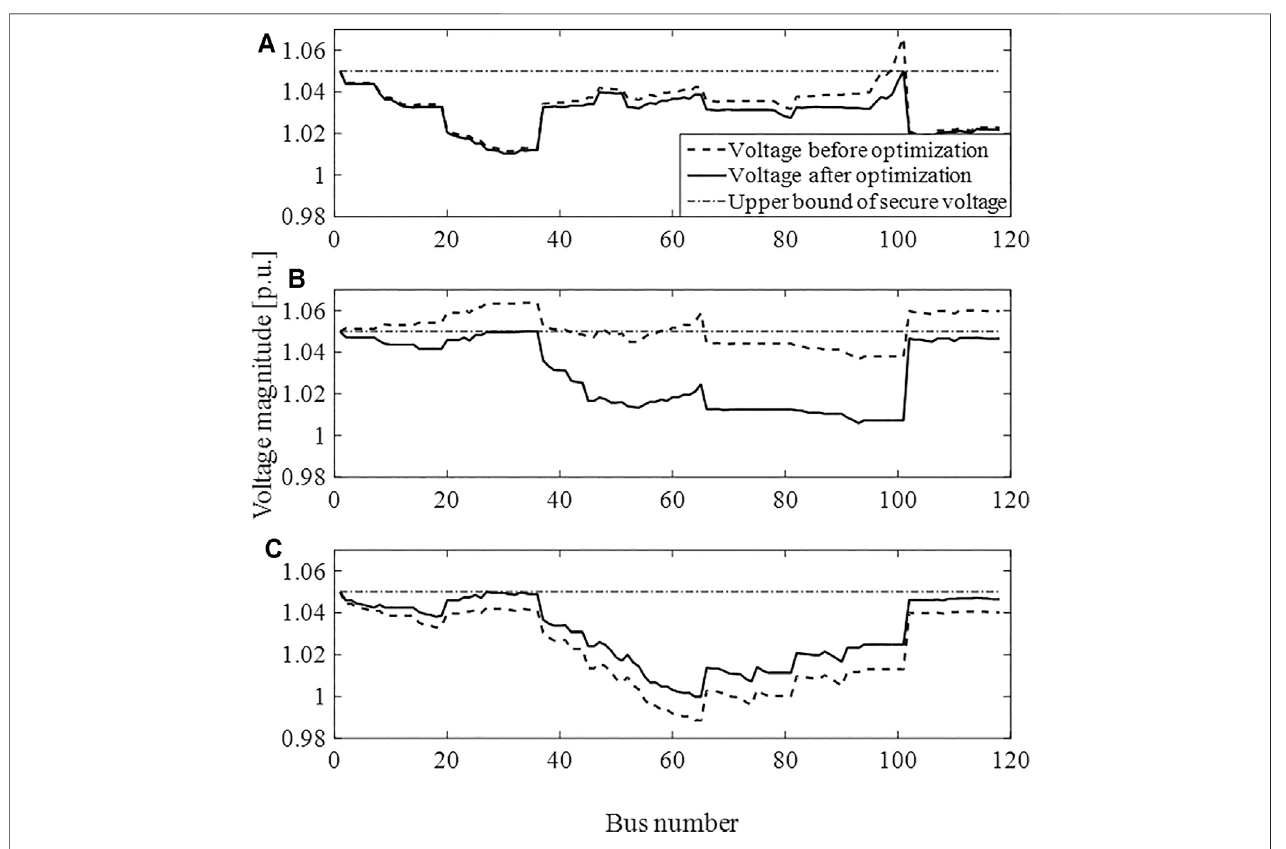
FIGURE 4 | Voltage magnitude comparison between before and after optimization: (A) phase A, (B) phase B and (C) phase C.